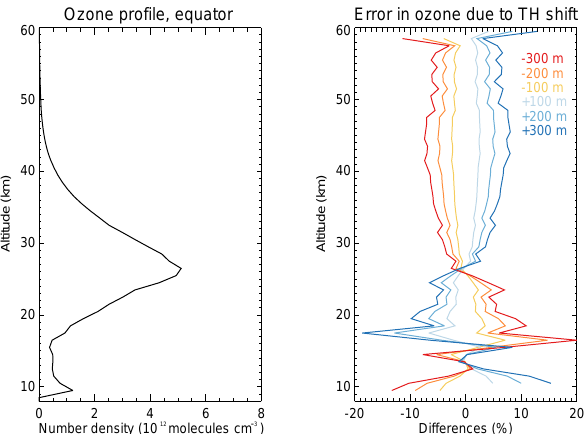
Figure 5. Typical ozone profile in the tropics (left panel). By shift- ing the ozone profile, we can estimate an order and pattern of error in ozone profiles due to TH shift (right panel). Errors in ozone re- trievals are within 8% at 40km from TH errors of 300m. Errors are least sensitive at the ozone peak (25 and 30km) and are more vari- able below. It is important to note that the shift of the ozone profile does not necessarily translate to the same error in altitude regis- tration for limb radiances due to the nonlinearity of the inversion, which is especially important at lower altitudes (below